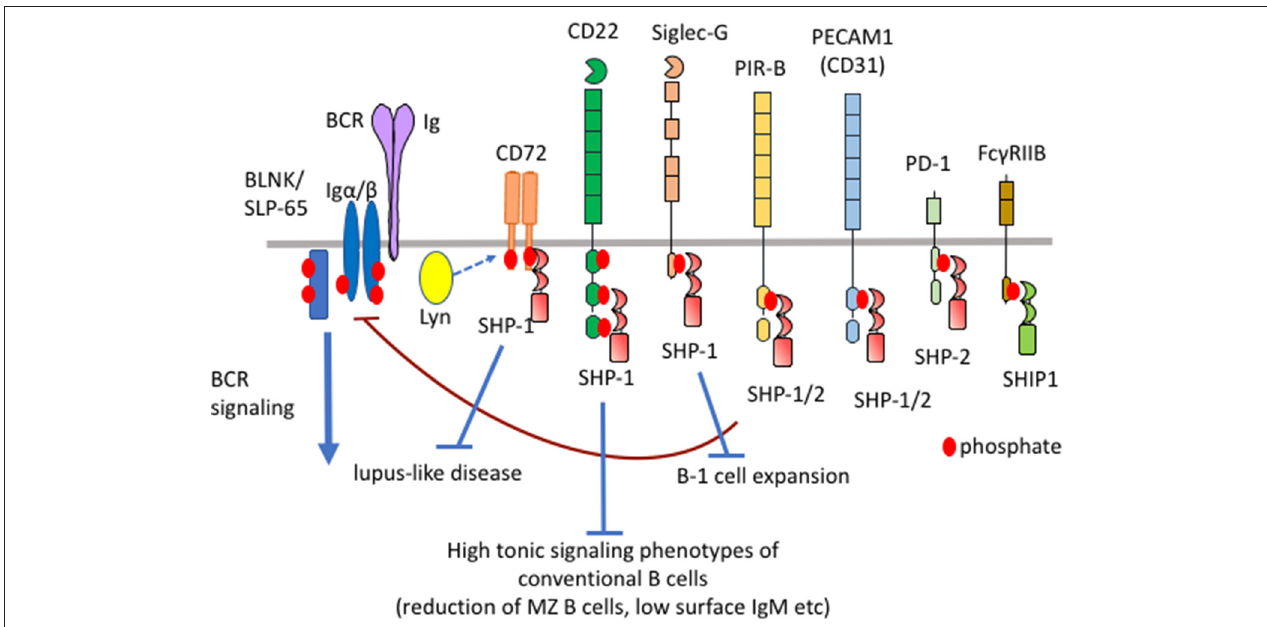
FIGURE 1 | Differential functional properties of inhibitory B cell co-receptors. Mouse B cells express various inhibitory co-receptors such as CD72, CD22, Siglec-G, PIR-B, PEACAM1, PD-1, and Fc γ RIIB. These receptors contain ITIMs in the cytoplasmic region and recruit SH2-containing phosphatases such as SHP-1, SHP-2, and SHIP-1 upon phosphorylation by Lyn, leading to down-modulation of BCR signaling. Although many of these inhibitory receptors activate SHP-1, CD72, CD22, and Siglec-G inhibits development of lupus-like disease, high tonic signaling phenotypes of conventional B cells, and B-1 cell expansion,